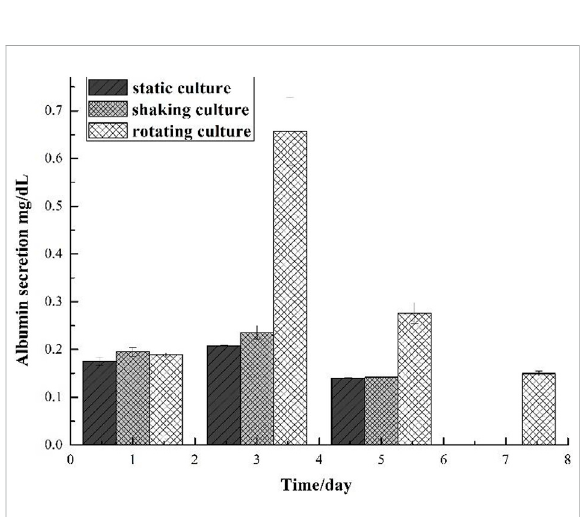
FIGURE 7 Comparison of albumin secretion of gel and cell microcapsulation composites in different culture system.